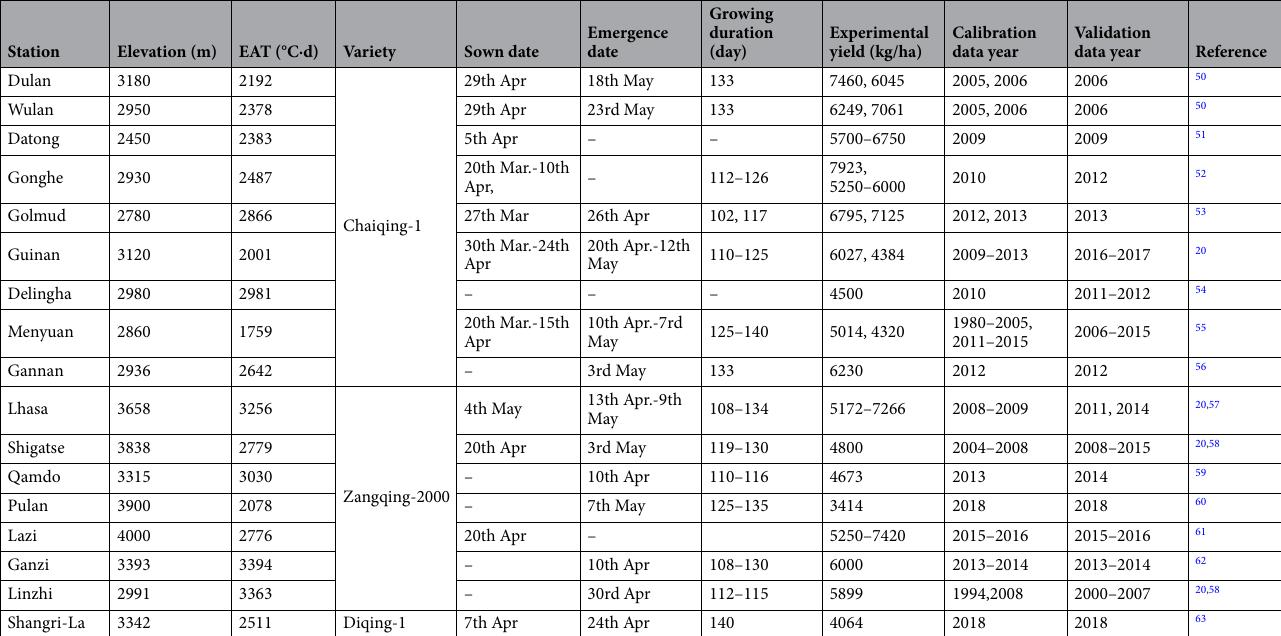
Table 1. Data set for calibrating and validating WOFOST model parameters. – indicates a lack value of